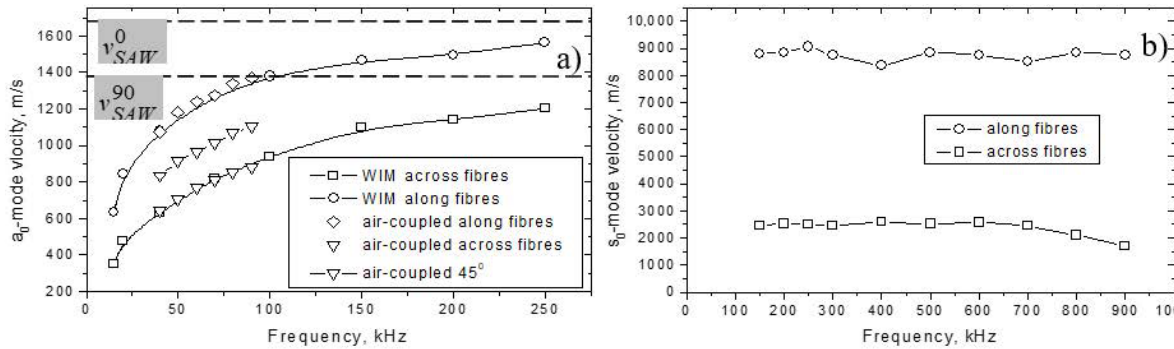
Figure 10. Measured velocities of a 0 ( a ) and s 0 ( b ) modes as functions of frequency in